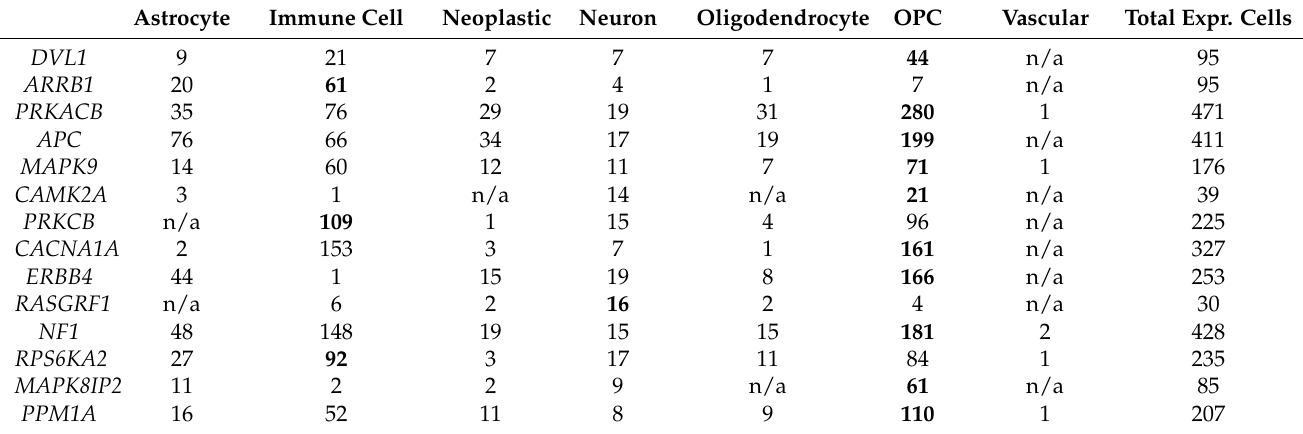
Table 3. CSC development-associated genes were mainly expressed by OPCs at the tumor border.